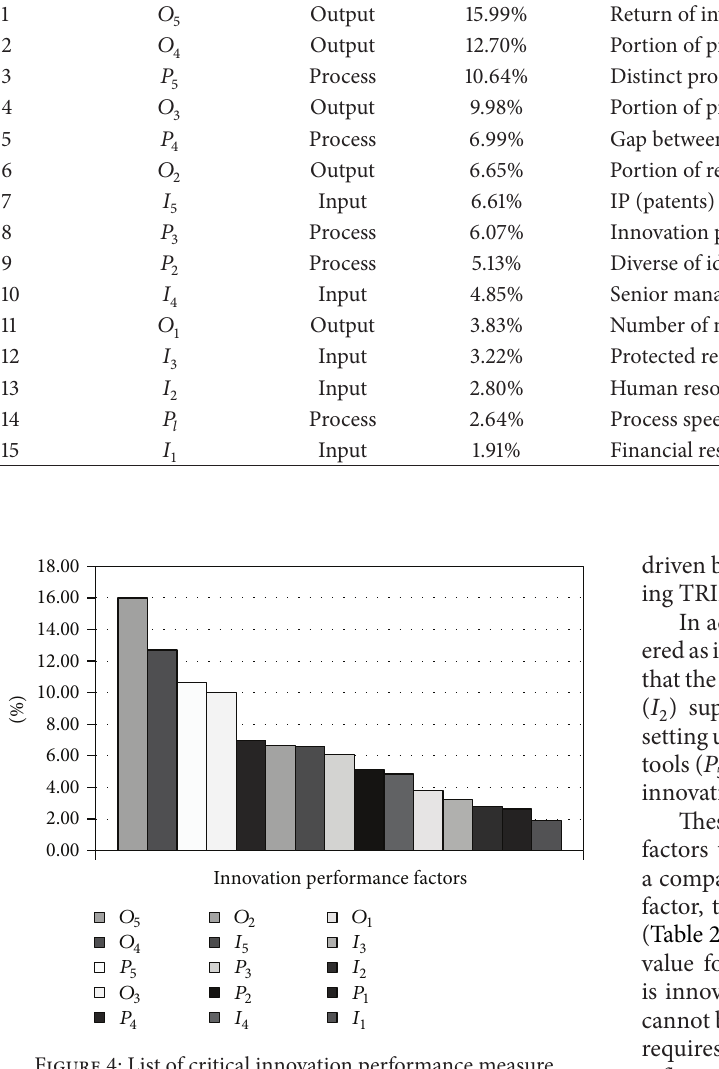
Figure 4: List of critical innovation performance